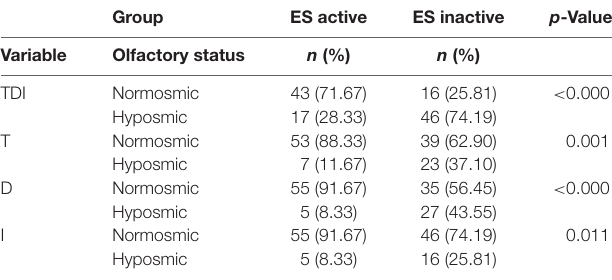
TABLE 1 | Distribution of the active and inactive Elderly Subjects (ES) classified as normosmic or hyposmic based on their overall olfactory status (TDI), Threshold (T), Discrimination (D), or Identification (I)